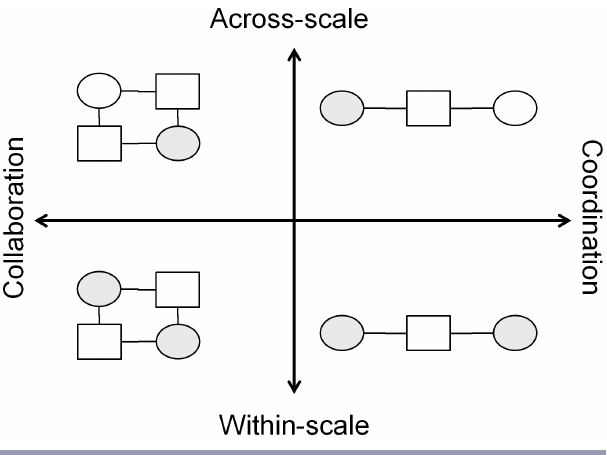
Fig. 4 . Conceptual framework. Squares indicate committees or working groups, and circles indicate stakeholders. Shaded circles imply stakeholders must be of a given scale, e.g. grower, local industry or local state government representative, state or national